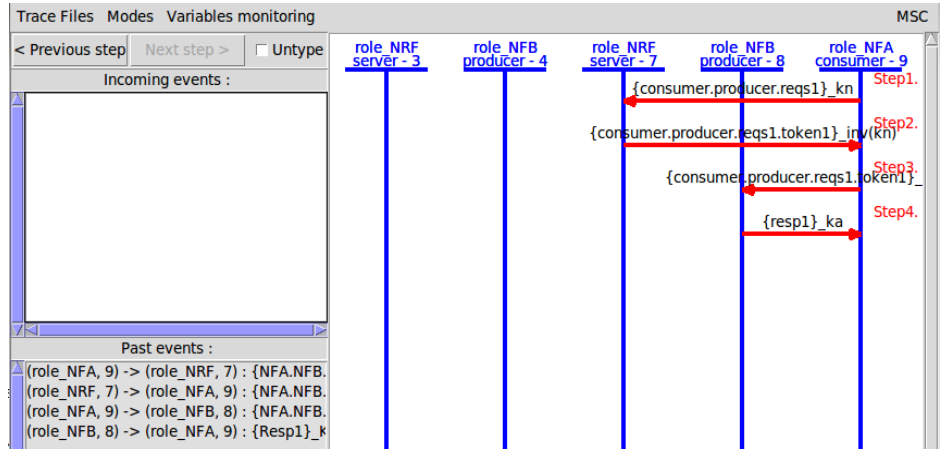
Figure 9. MSC of SPAN simulating service access procedure.